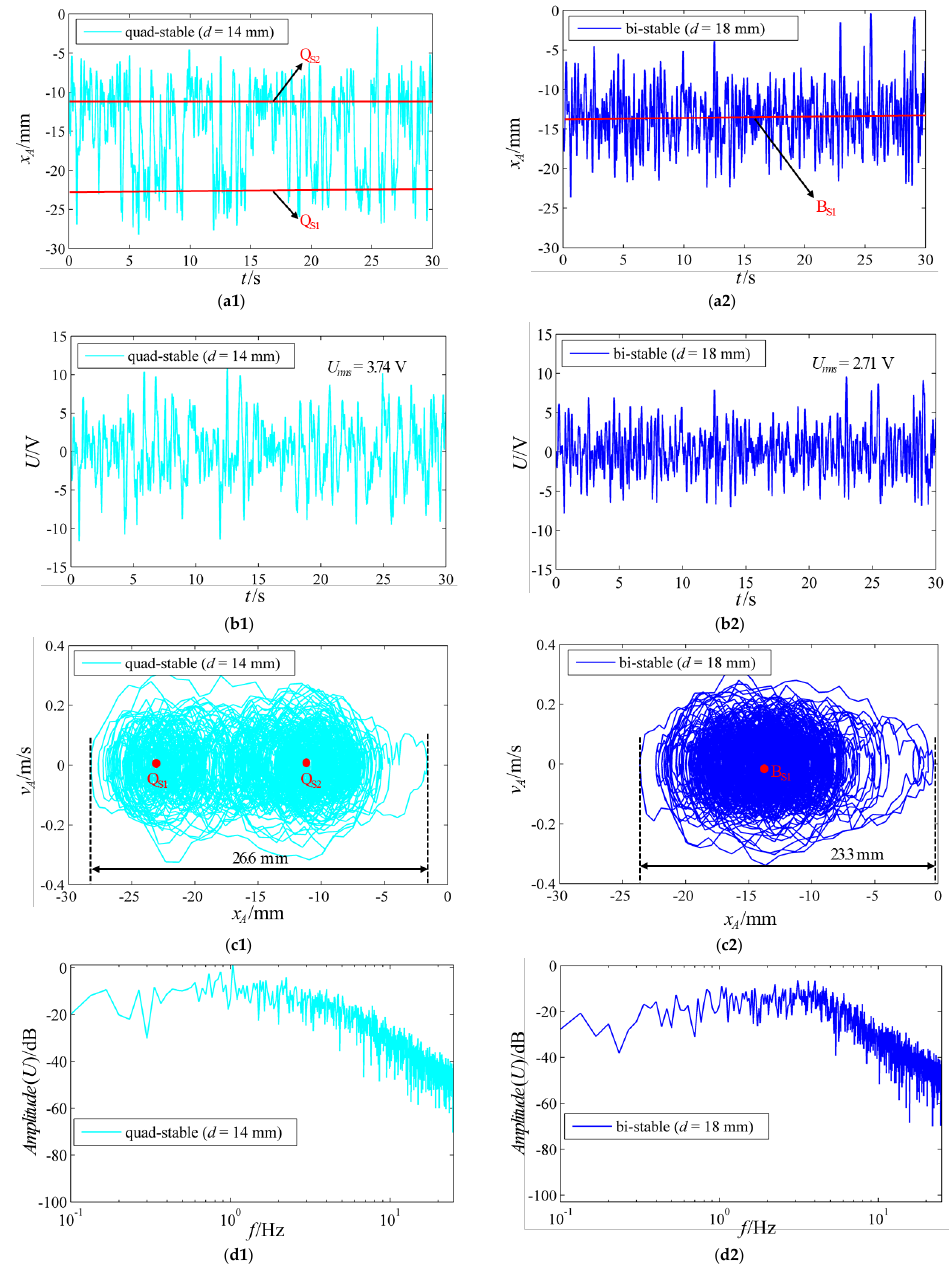
Figure 4. The ( a1 ) output displacement, ( b1 ) open circuit voltage, ( c1 ) phase portrait, and ( d1 ) PSD of the voltage under the quad-stable structural parameters when a Arms = 0.88 g; the ( a2 ) output displacement, ( b2 ) open circuit voltage, ( c2 ) phase portrait, and ( d2 ) PSD of the voltage under the bi-stable structural parameters when a Arms = 0.88 g.